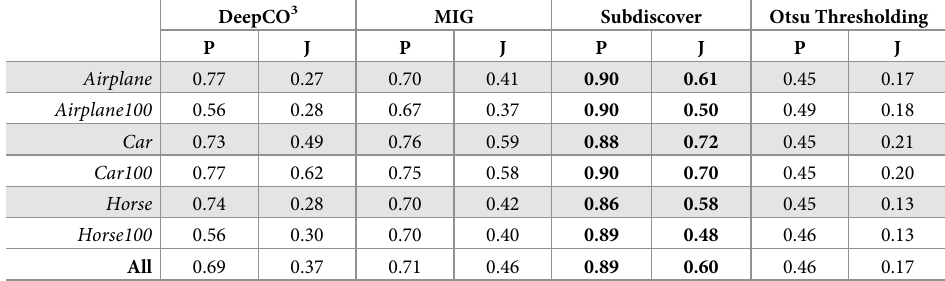
Table 4. Results of three cosegmentation methods and one plant phenotyping segmentation method on the Inter- net dataset. DeepCO 3 MIG Airplane Airplane100 Car Horse Horse100 All 0.17 P is Precision and J is Jaccard. Bold text scores indicate the highest score of both Precision and Jaccard per group. “All” is the average score on the whole